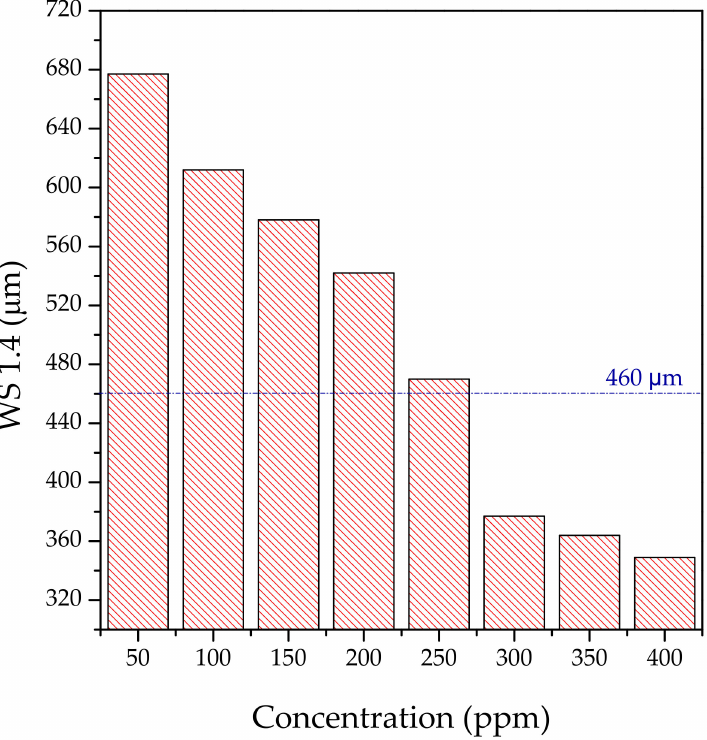
Figure 5. Impact of cottonseed oil N , N -Bis(2-ethoxyethyl) amides addition on the lubrication charac- teristics of the base